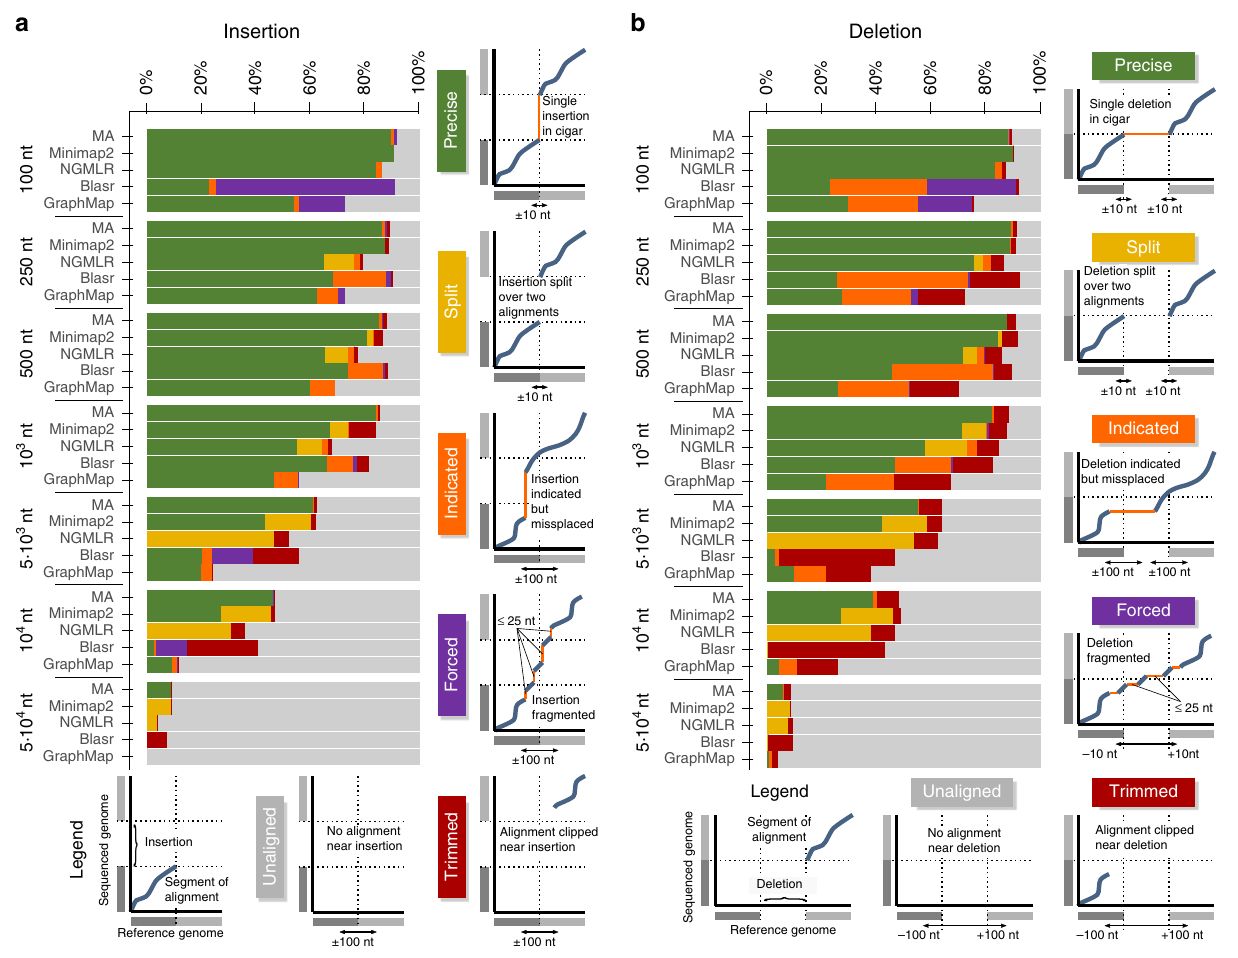
Fig. 4 SV mapping. Several aligners (MA, Minimap2, NGMLR, Blasr and GraphMap) are compared with respect to their abilities to map insertions ( a ) and deletions ( b ) originating from structural variants (SV). The numbers to the left of the aligner names indicate the sizes of injected SVs. Textual de fi nitions of the different categories precise, split, indicated, trimmed, forced and unaligned are given in Supplementary Note 2. Each bar reports about the observed distribution for 1000 reads that are generated using the sampled mean error of the UON